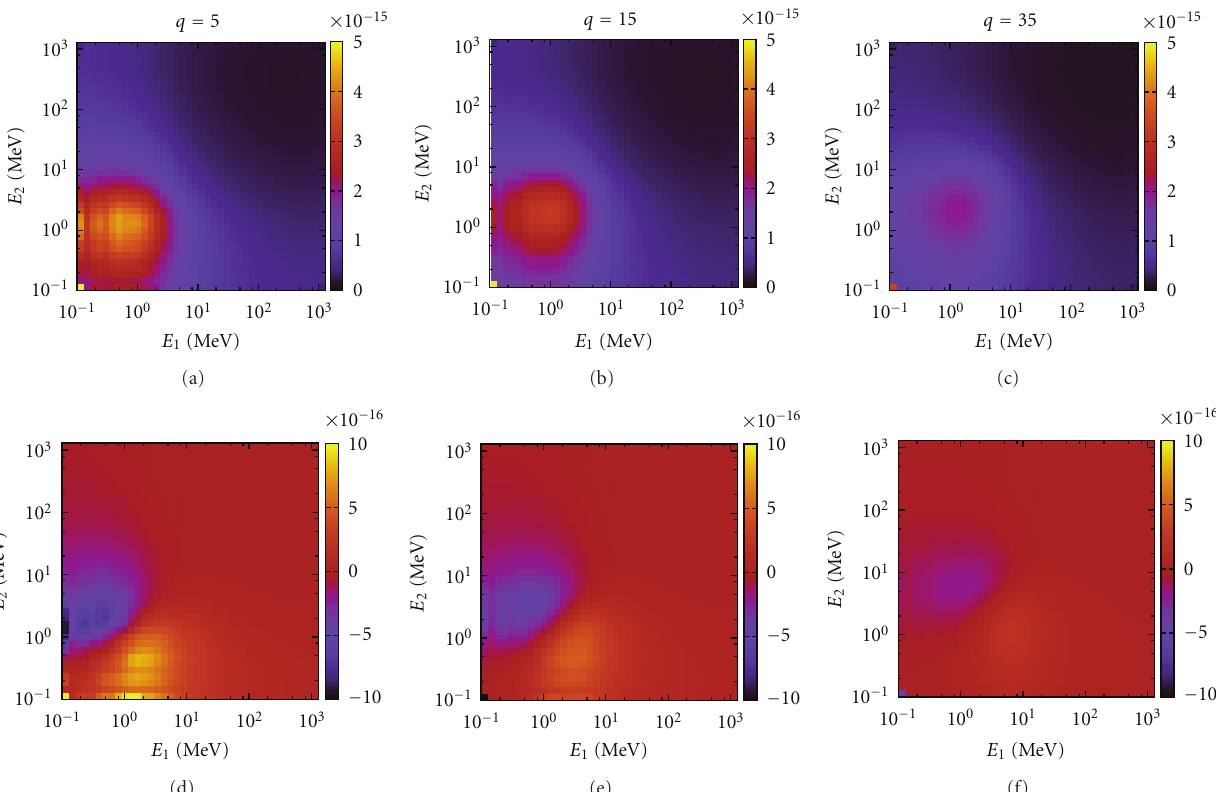
Figure 10: Two-energy distributions f q ( E i , E j ) (a)–(c) for di ff erent neutron numbers ( q ) and the corresponding covariance functions E E C f q ( 1 , 2 ), (d)–(f) for the thin target (